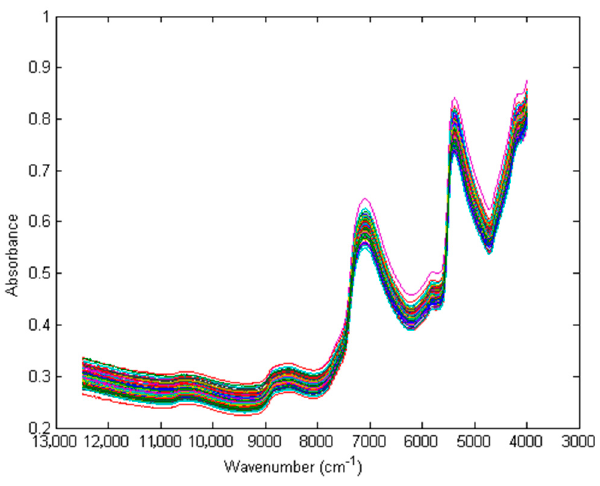
Figure 1. Raw absorbance spectra of Pinus massoniana seedling leaves, where each line is a spectrum of a Pinus massoniana seedling leaf, including 2203 wavelength variables.